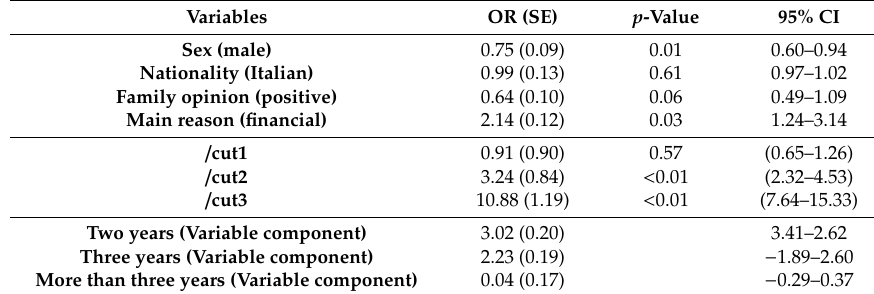
Table 6. Multilevel ordinal logistic regression about planning to open one’s own practice by sex, nationality, family and main reason to open the practice. The table includes the fixed-e ff ect portion of our model, the estimated cut-points and the estimated variance